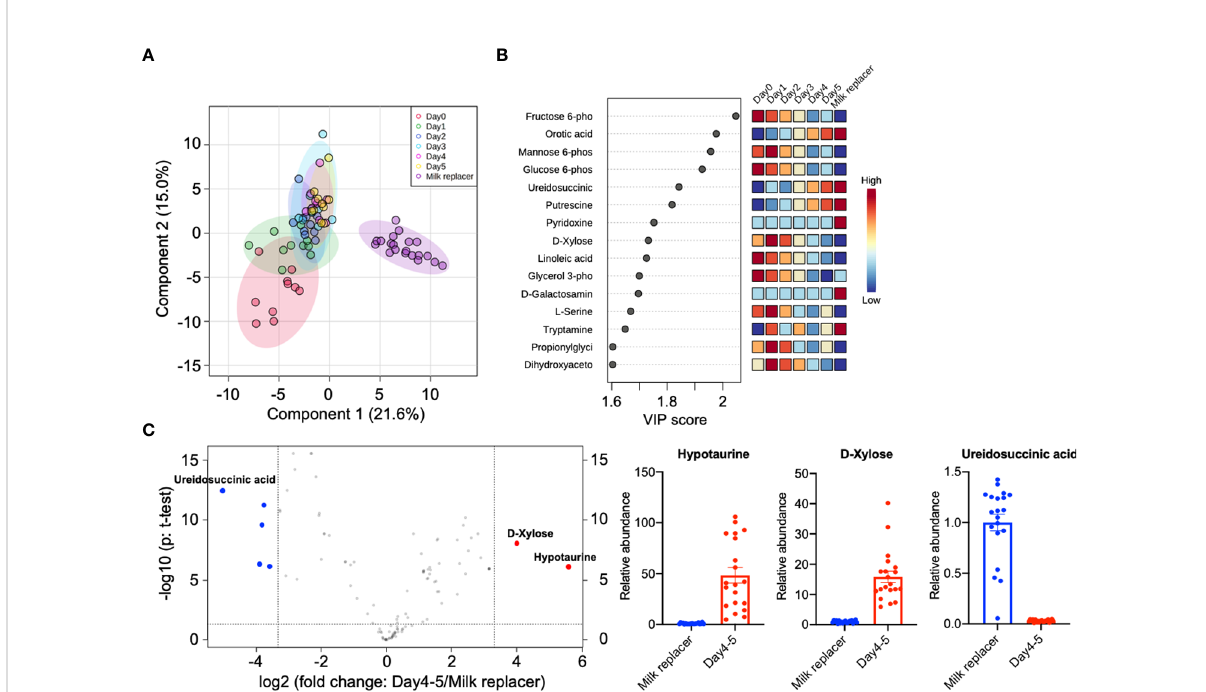
FIGURE 3 Differences in metabolic components between whole milk and milk replacer. (A) 2D principal component analysis score plot of colostrum (day 0, n = 10), whole milk (days 1, 2, 3, 4, and 5 after parturition, n = 10 each), and milk replacer ( n = 20). (B) Important features identi fi ed by partial least-squares discriminant analysis (PLS-DA). The colored boxes on the right indicate the relative concentrations of the corresponding metabolites in each group. (C) Statistically signi fi cant features with a fold change threshold of 10 ( x -axis) and a t -test threshold of p < 0.05 ( y -axis) selected by a volcano plot. The red circles represent higher metabolites in whole milk on days 4 and 5 and the blue circles represent higher metabolites in milk replacer. On the right, histograms show the relative abundance of hypotaurine, D-xylose, and ureidosuccinic acid in milk replacer and whole milk on days 4 and